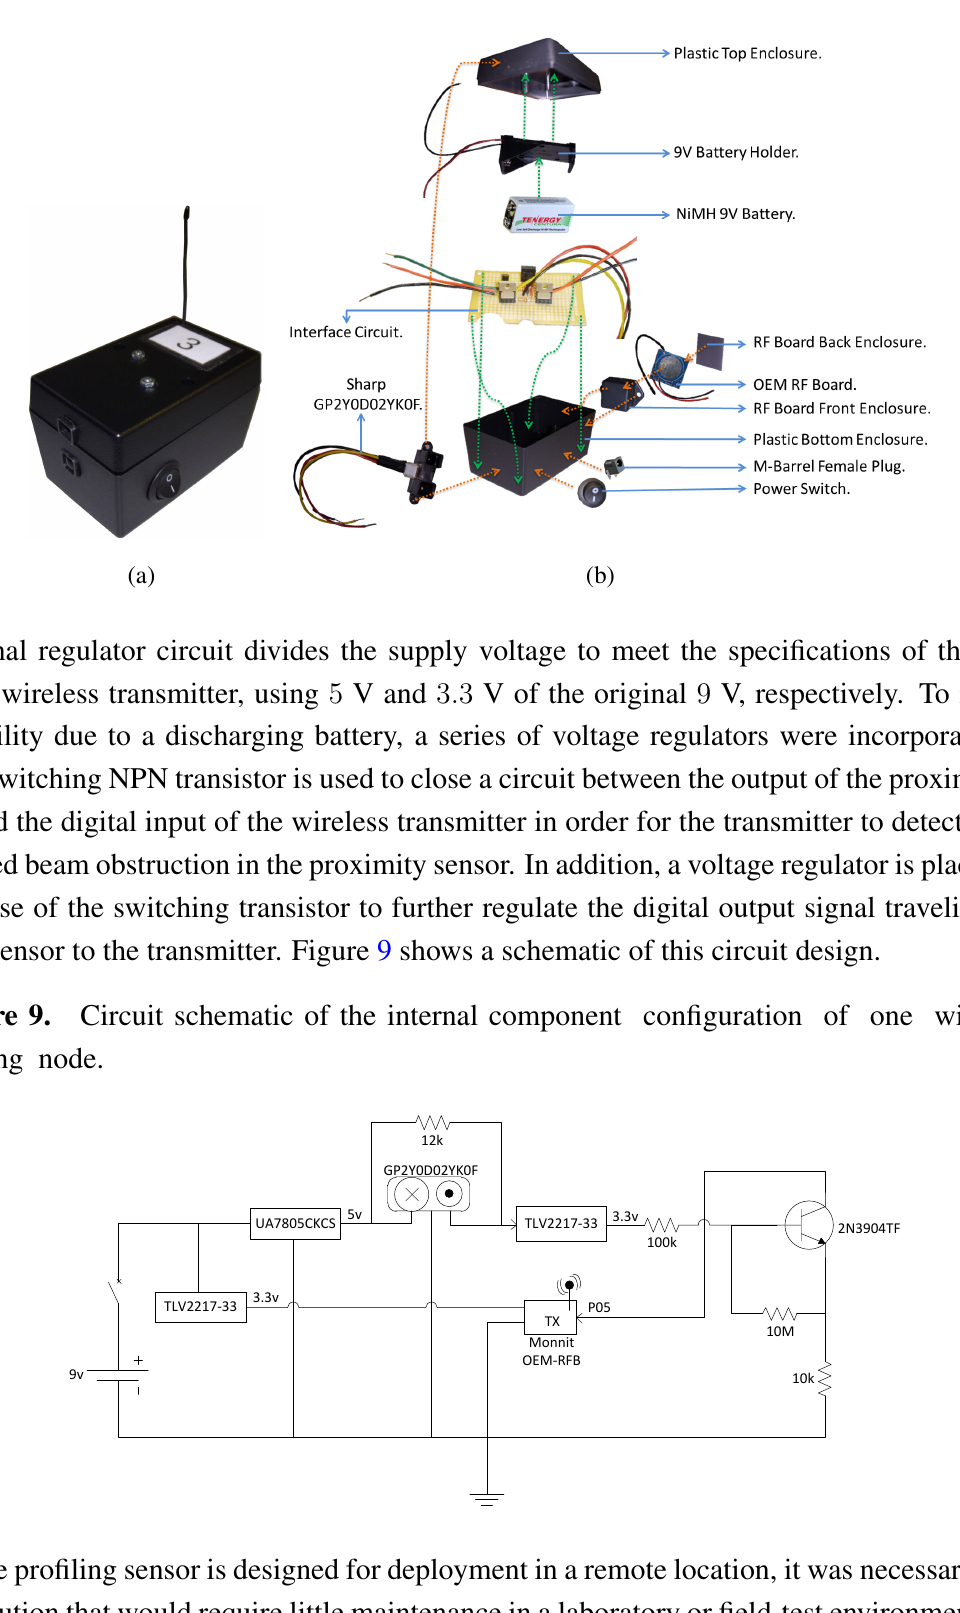
Figure 8. Wireless sensing node ( a ) Assembled view of one node; ( b ) Exploded view of one sensing node showing its internal components.